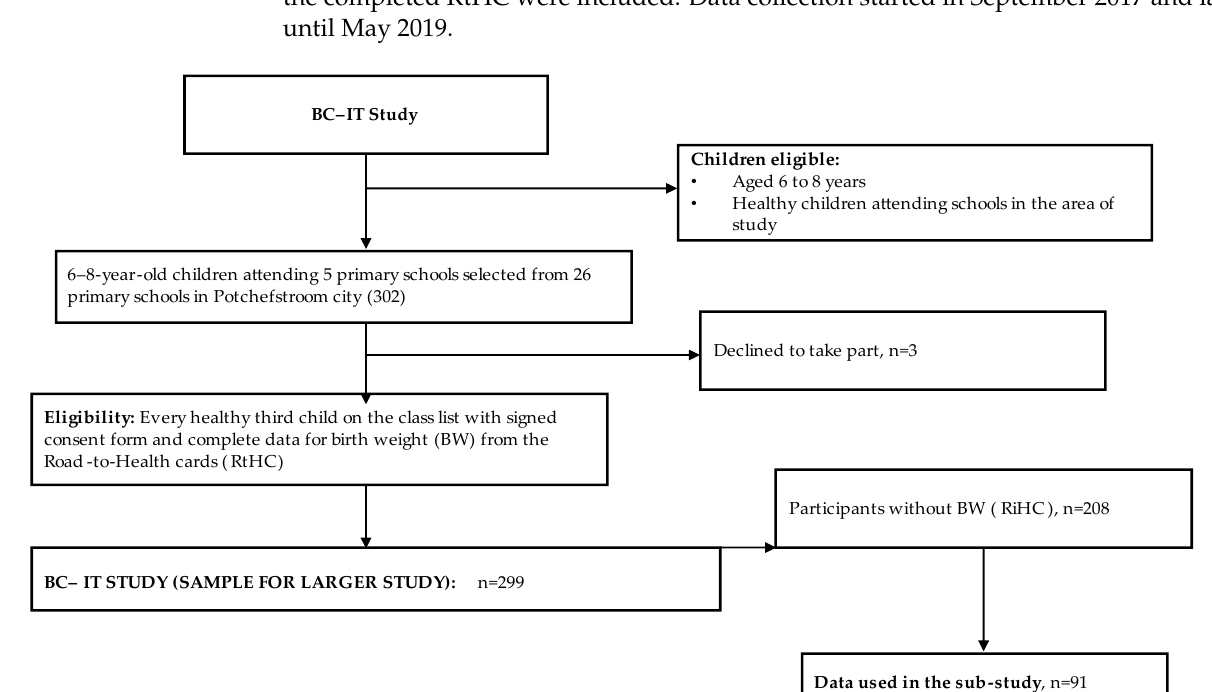
Figure 1. Flow diagram for the larger body composition using the isotope technique (BC-IT study) study.